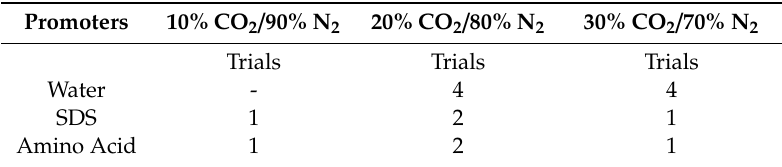
Table 3. Experimental plans for constant